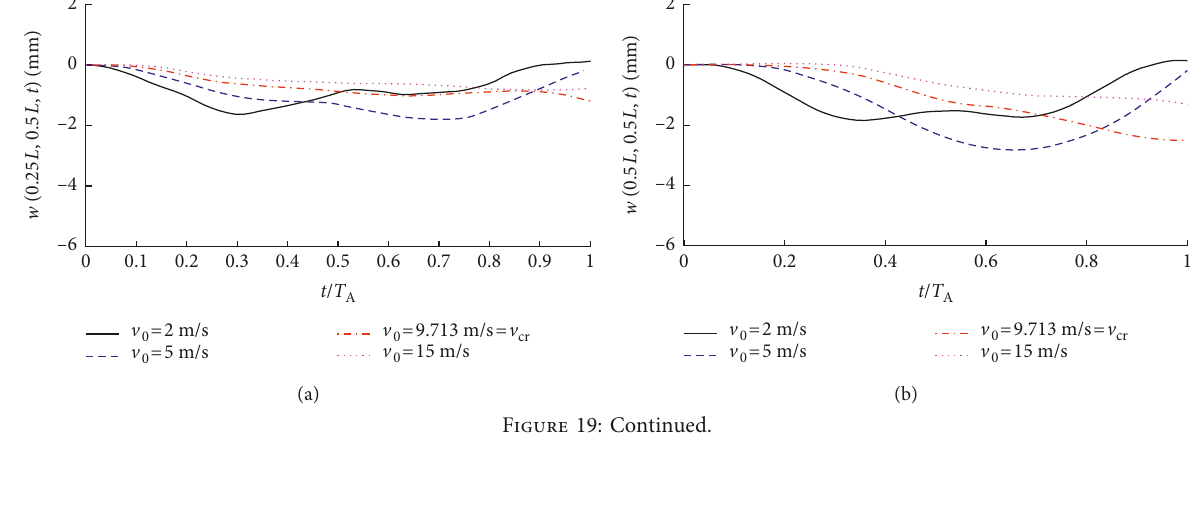
v 0 =2 m/s v 0 =5 m/s